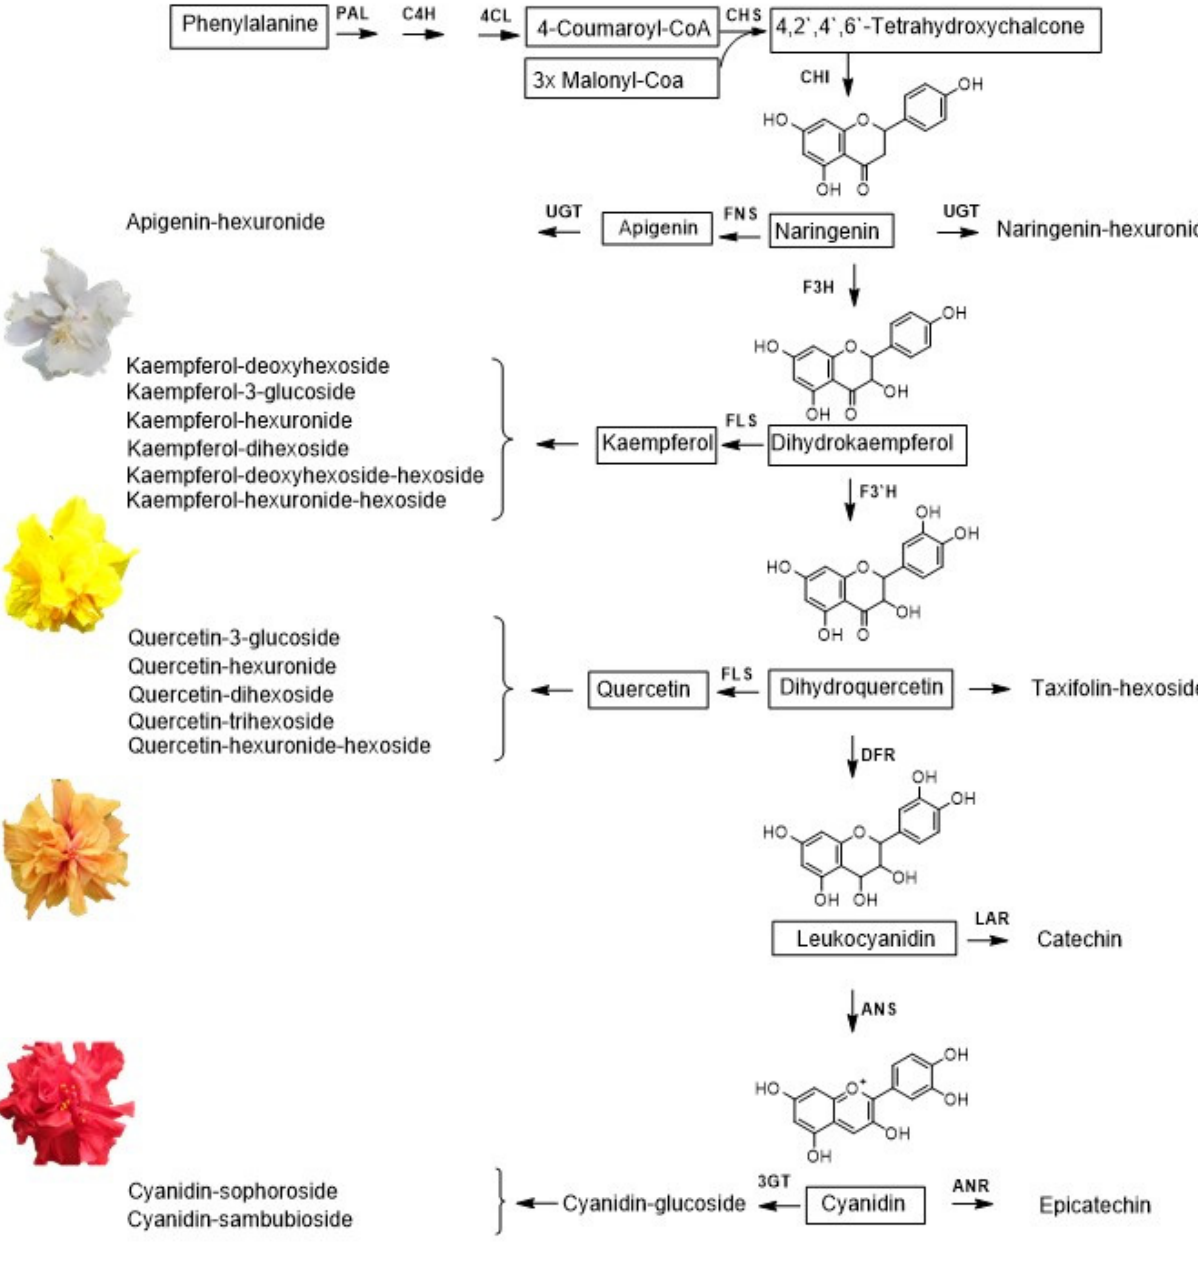
Figure 6. General scheme of flavonoid biosynthesis in Hibiscus rosa-sinensis flowers. PAL (phenylalanine-ammonium lyase), C4H (cinamate-4-hydroxylase), 4CL (4-coumarate CoA ligase), CHI (flavanone chalcone isomerase), FNS (Fla-vanone synthase), UGT (glucuronyltransferase), F3H (flavanone-3-hydroxylase), FLS (flavonol synthase), F3‘H (flavonoid-3‘hydroxylase), DFR (dihydroflavonol-4-reductase), LAR (leukucoanthocyanidin reductase), ANS (anothocyanin syn- thase), ANR (anthocyanidin reductase), 3GT (anthocyanidin-3-glucosyltransferase). Adapted from Hammerbacher et al. [54], Gerats, T. and Strommer [55] and Hong et al. [56]. Patel et al. [13] carried out a comparative study of the extracts of red, pink, orange, yellow and white cultivars of leaves, stems and roots of Hibiscus rosa-sinensis and found the highest and lowest total phenol content in the red and white cultivars, respectively. To